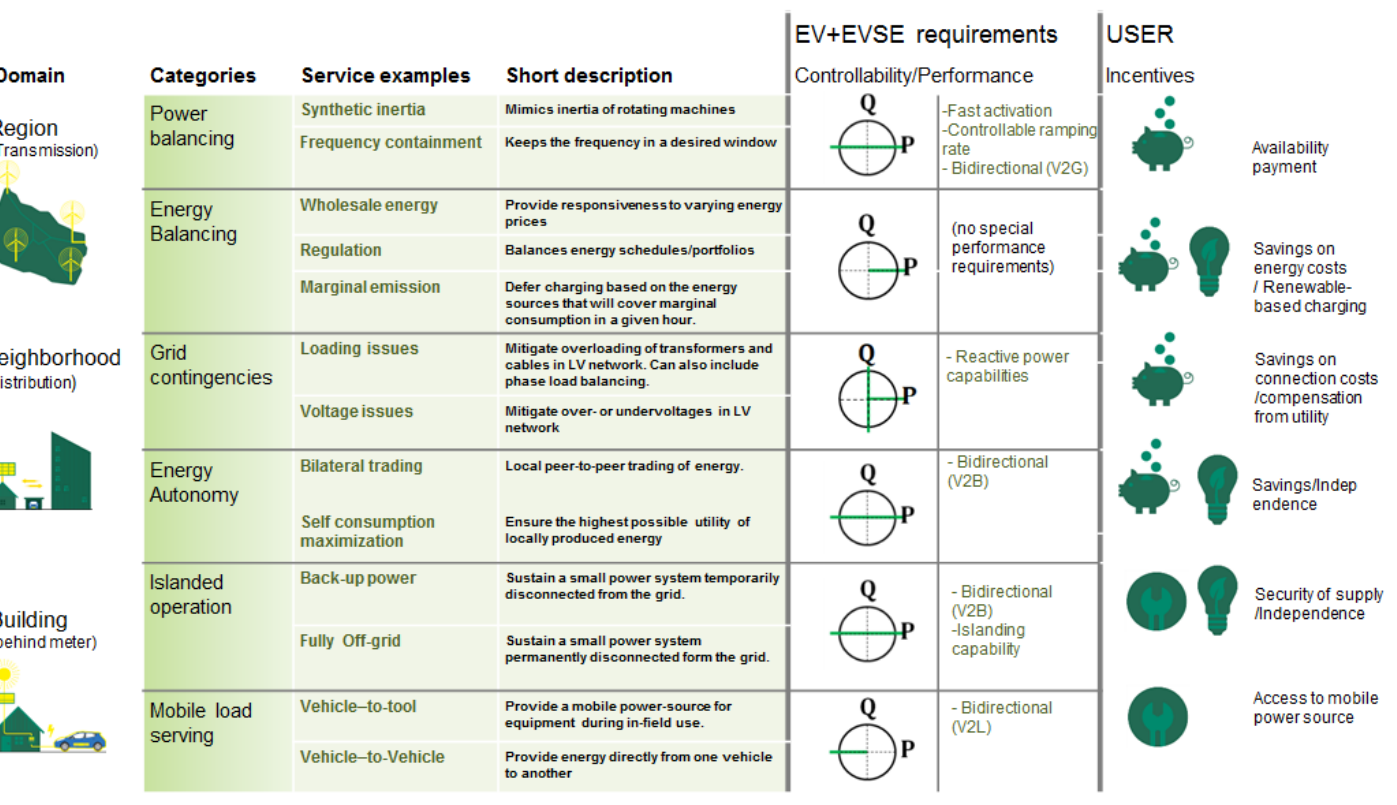
Figure A1. Full Parker service